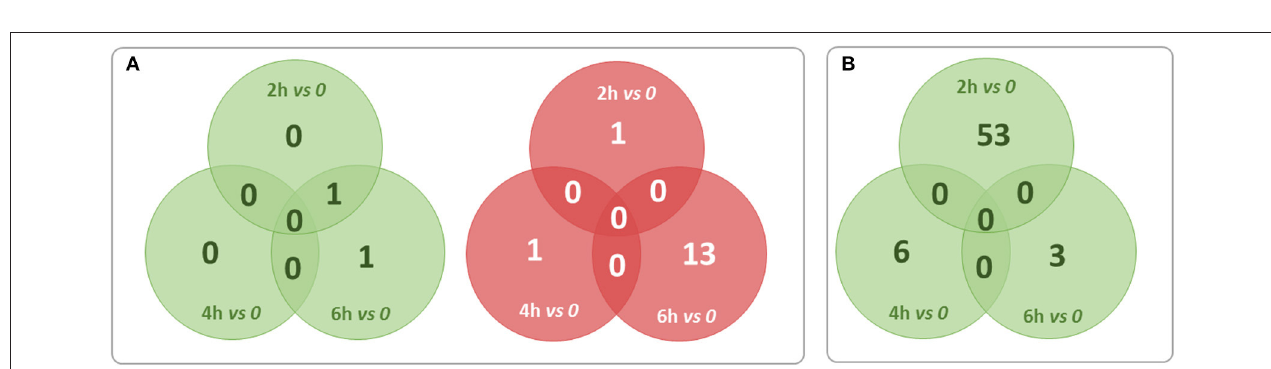
FIGURE 2 | Overlaps between lncRNA transcripts differentially expressed at different time points in CF and non-CF datasets. Red circles represent down-regulated transcripts and green circles represent up-regulated transcripts. (A) 2 h in comparison with 0 h time point, (B) 4 h in comparison with 0 h time point, (C) 6 h in comparison with 0 h time point.